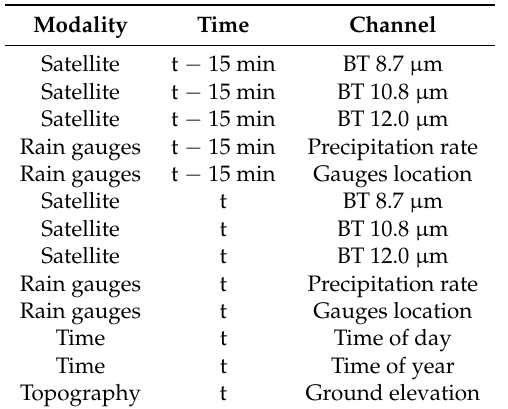
Table 1. List of all input channels, with their modality and timestamp. t corresponds to the time at which the model is making an estimation of the precipitation